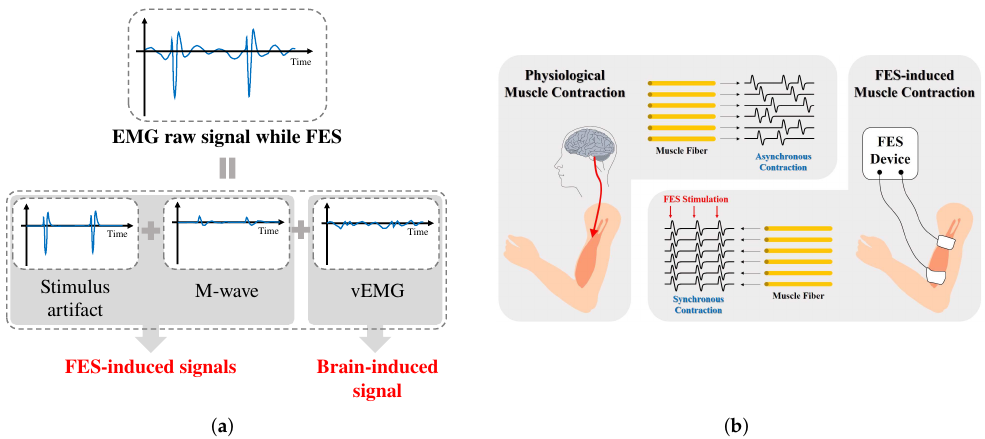
Figure 2. Conceptual design of EMG signals during FES: ( a ) Components of contaminated EMG signal during FES and ( b ) comparison of physiological muscle contraction and FES-induced muscle contraction.